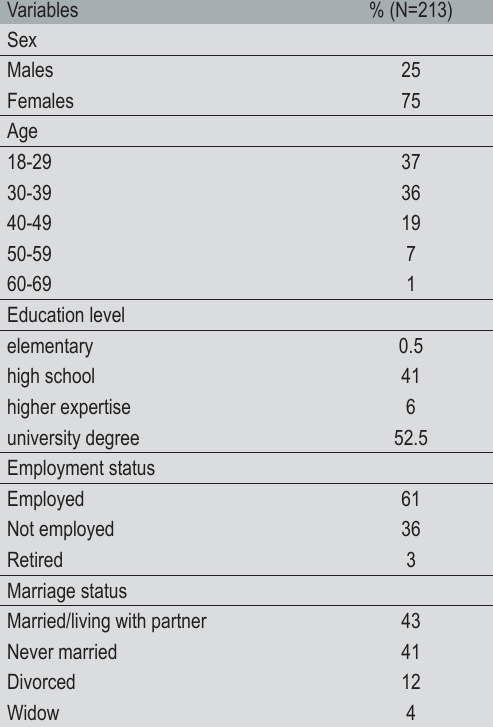
TABLE 1. Demographic traits of patients involved in psycho- therapy in Bosnia and Herzegovina